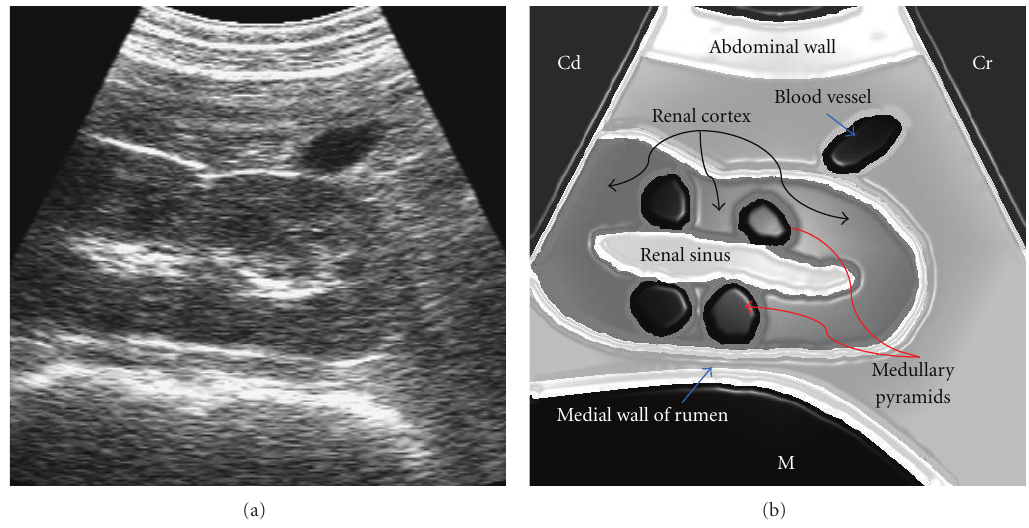
Figure 4: Ultrasonogram of the left kidney imaged from the right paralumbar fossa, by placing the transducer parallel to the longitudinal axis of the cow, just below the transverse processes of the lumbar vertebrae 3–5. Cr: cranial, Cd: caudal, and M: